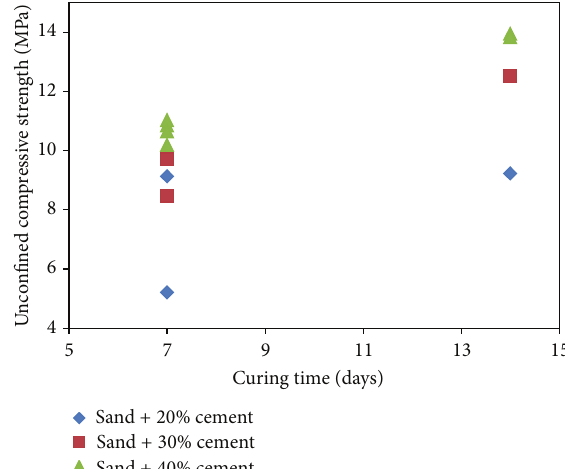
Figure 5: The unconfined compressive strength for specimens in water.